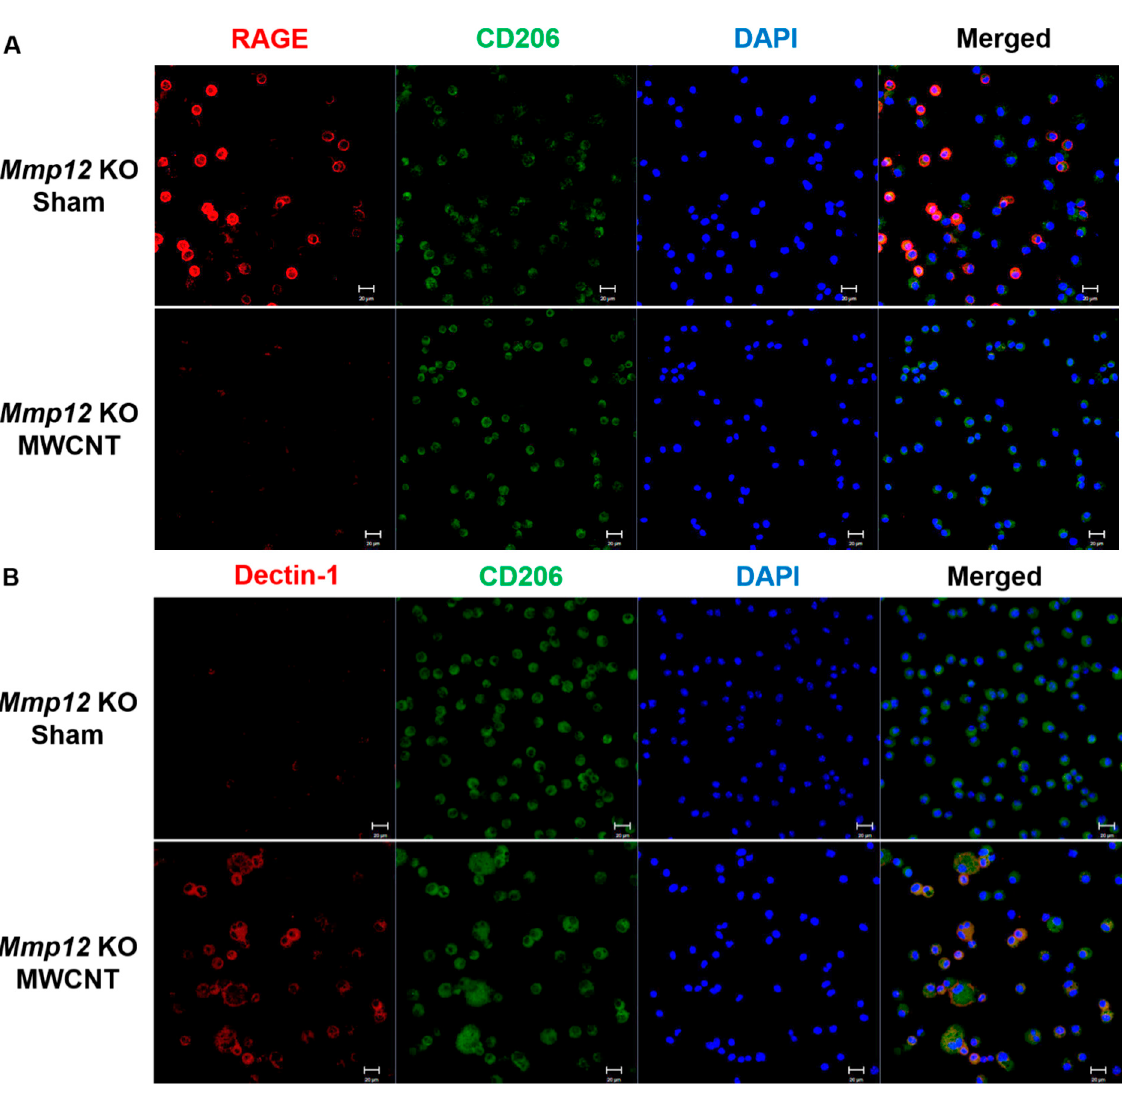
Figure 3. Dectin-1, an M2a macrophage phenotype, is prevalent in 60-day BAL cells from MWCNT-instilled Mmp12 KO mice. ( A ) Immunofluorescent staining at 60 days showed high levels of RAGE expression in 60-day BAL cells from Mmp12 KO sham, but low expression in MWCNT-instilled Mmp12 KO mice. ( B ) Dectin-1 was not detected in BAL cells from Mmp12 KO sham, but was highly expressed in BAL cells from MWCNT-instilled Mmp12 KO mice. Representative images of n ≥ 3 animals.